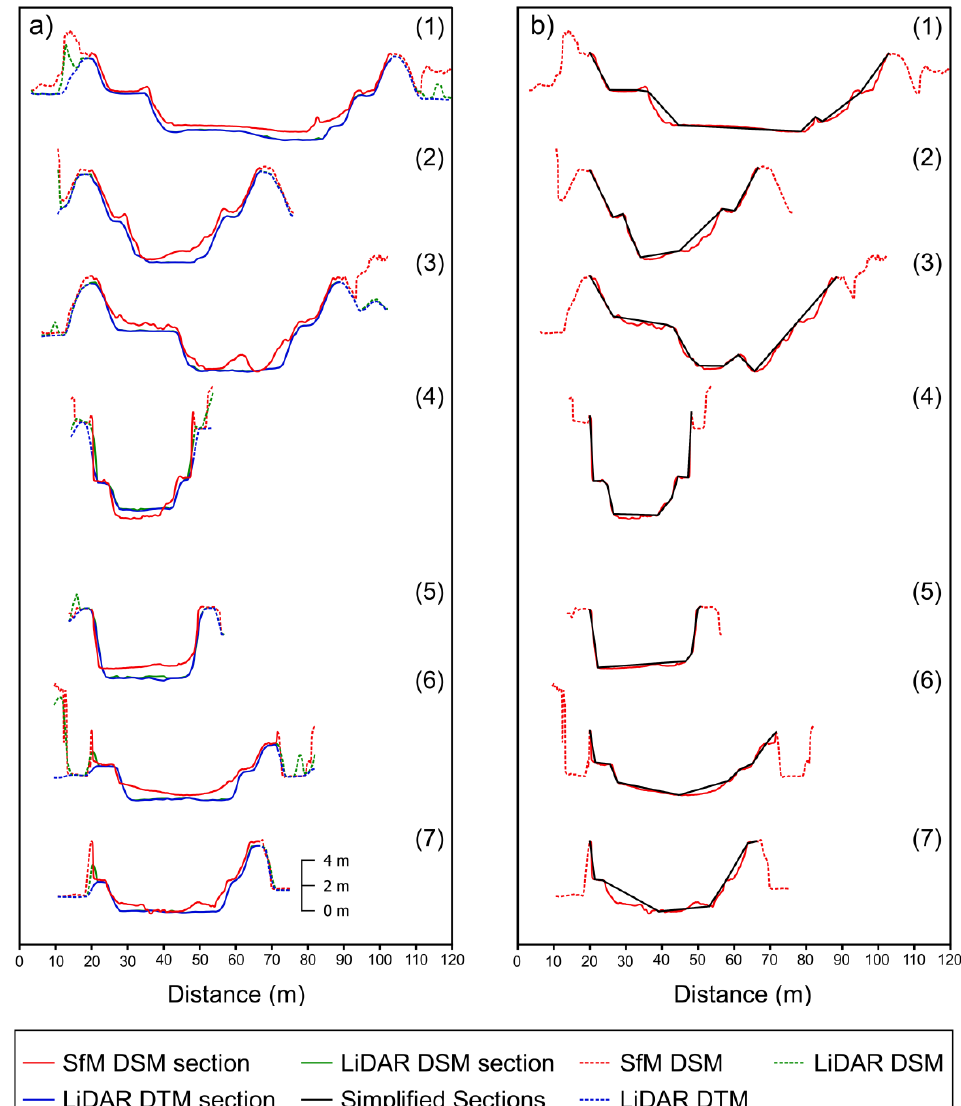
Figure 7. Comparison of the cross-section profiles derived from di ff erent topographic data. See Figure 2 for the locations of the cross-sections along the channel. ( a ) Profiles derived from SfM DSM, LiDAR DSM and DTM. ( b ) Profiles derived from SfM DSM and Simplified Sections.